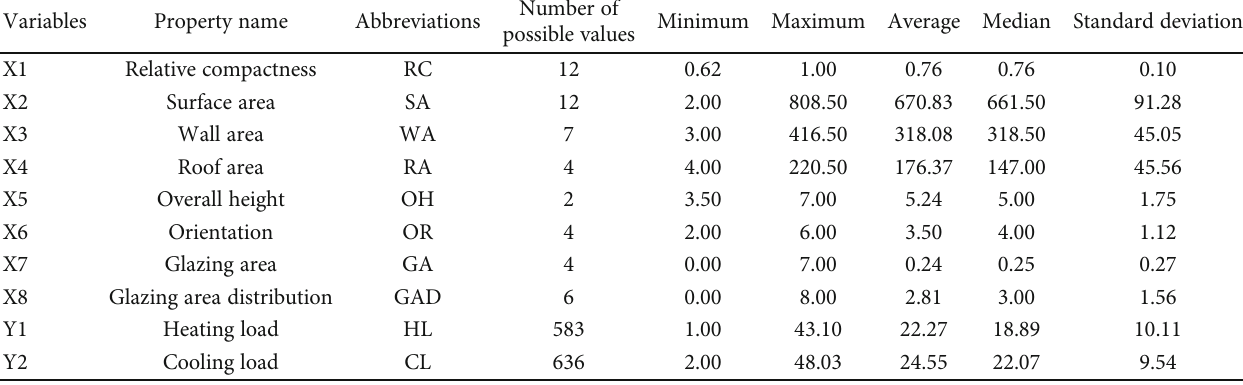
Table 2: Description of the data